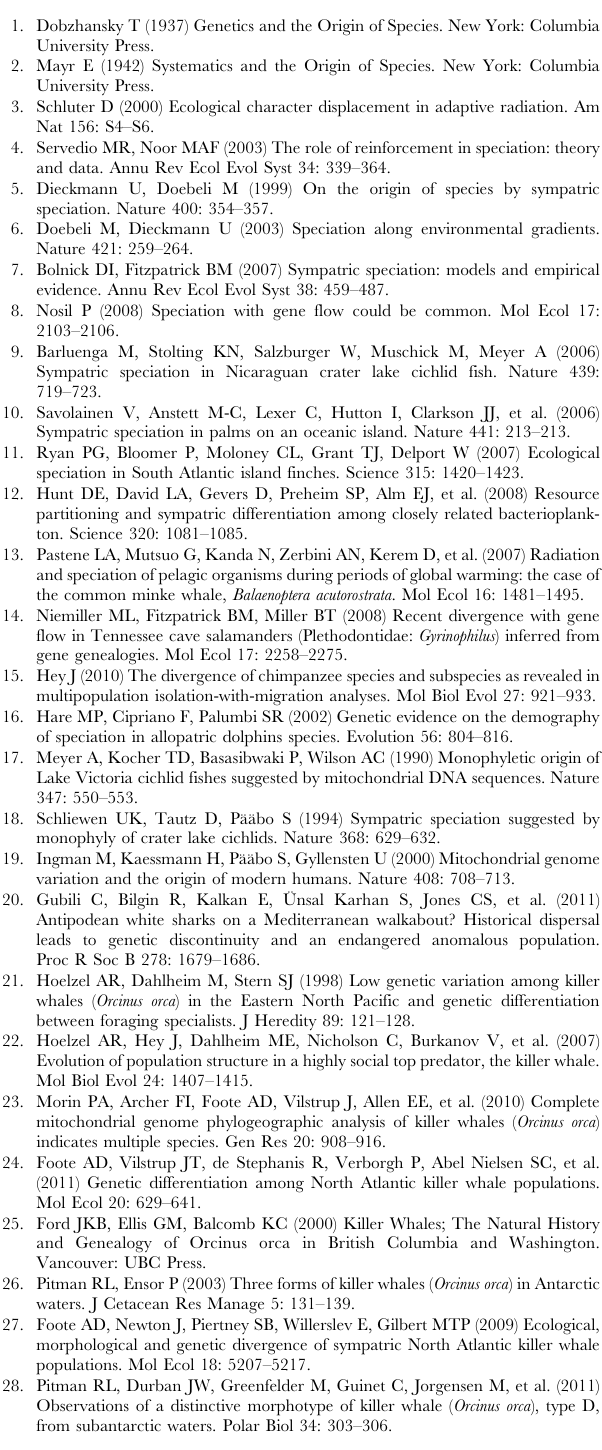
Table S1 List of GenBank accession numbers of sequences used in this